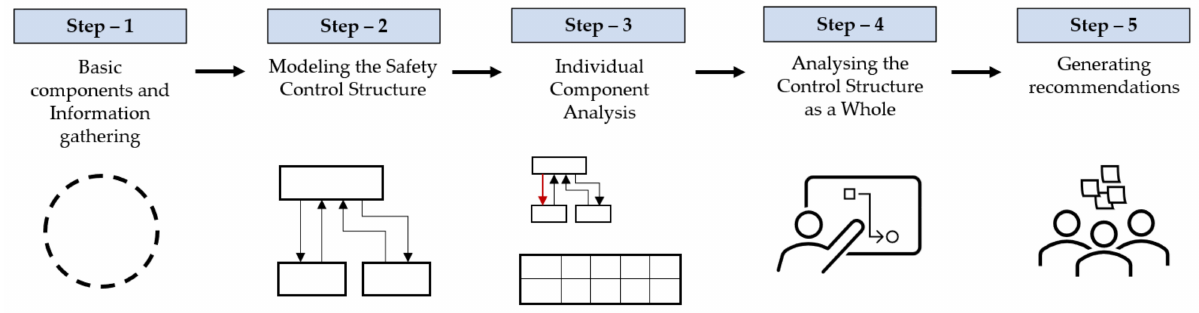
Figure 1. Methodology to perform a CAST